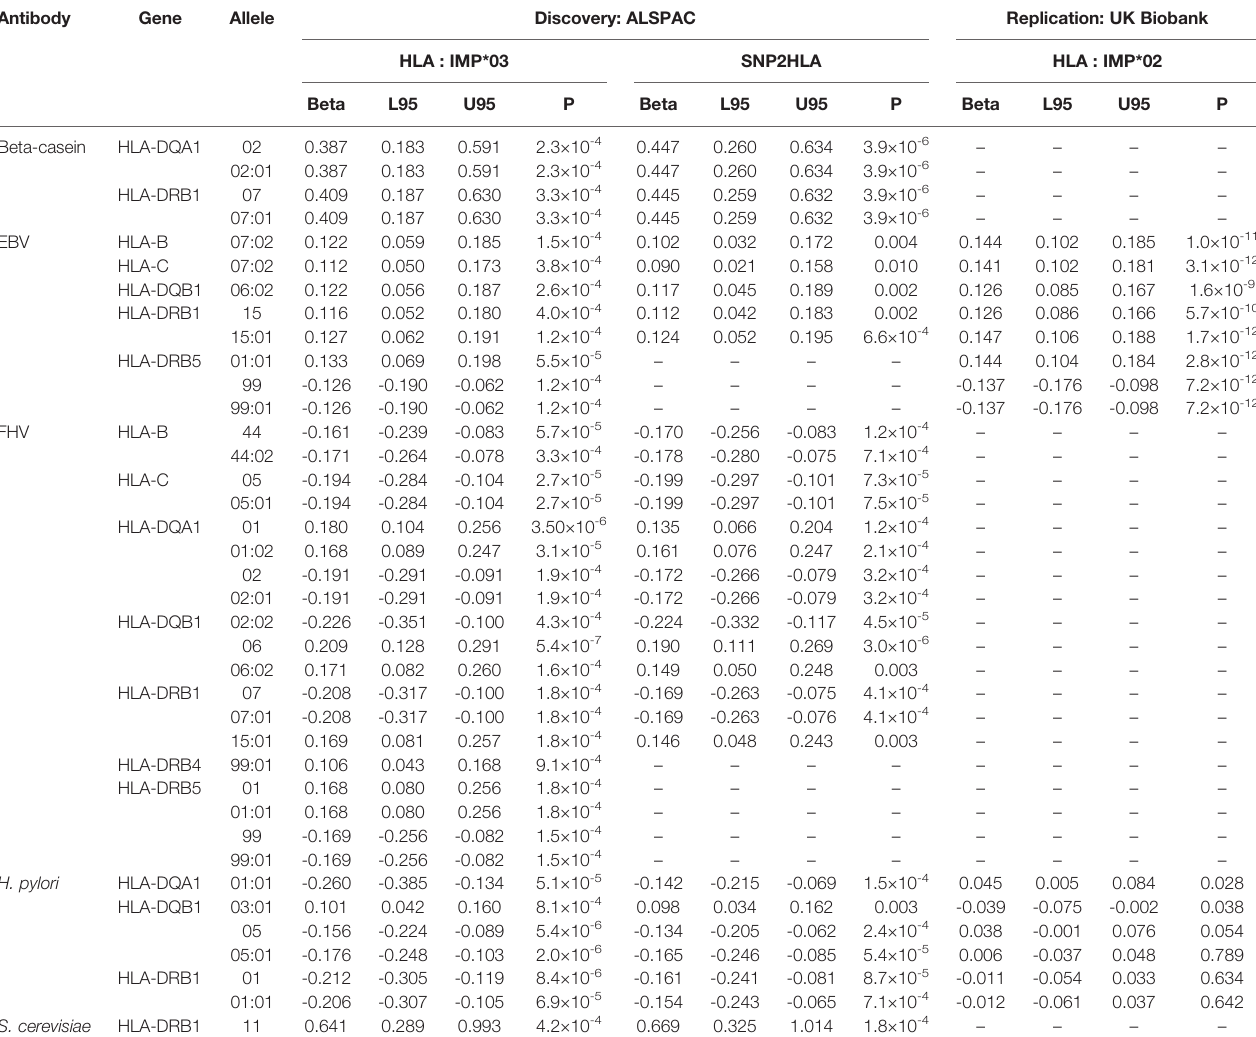
(-)referstoHLAallelesnotpresentinreferencepanel.ShadedcellsrefertoantibodiesnotmeasuredinUKBiobank.Beta,Betaestimateforthepresenceallele;L95,lower95%con fi dence interval; U95, Upper 95% con fi dence interval; P,